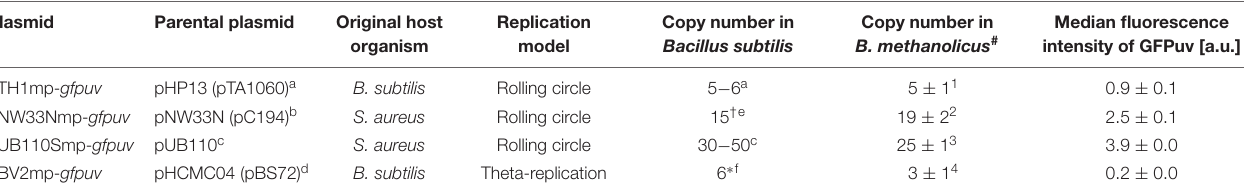
TABLE 1 | Comparison of properties and gfpUV expression from methanol-inducible promoter P mp of plasmids used in the study. Plasmid Parental plasmid Replication